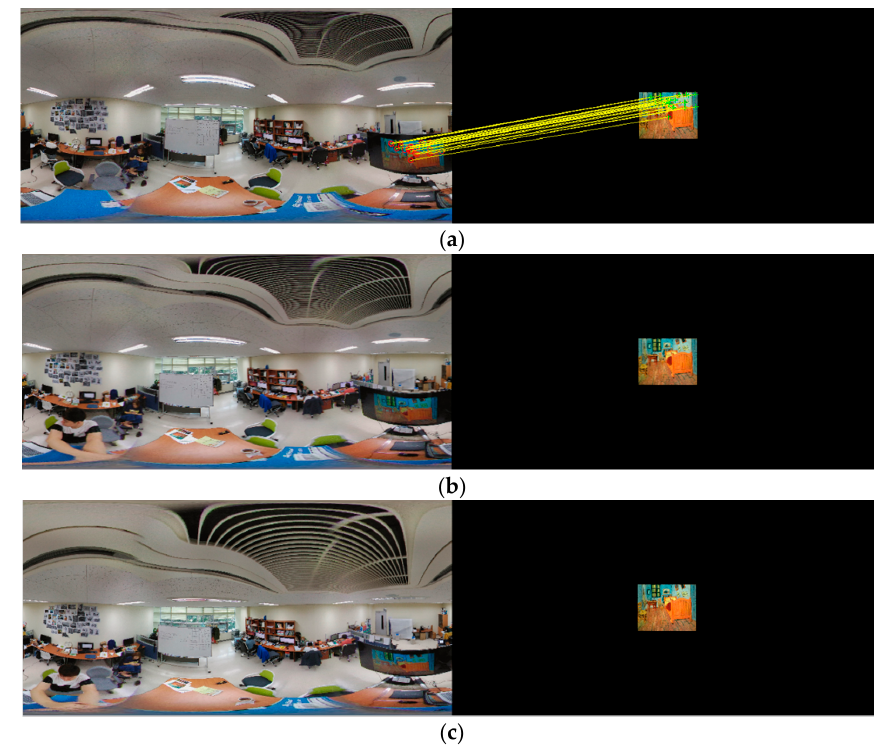
Figure 12. Matched results for the 79-inch monitor for three types of distortions. ( a ) Matched results for low distortion; ( b ) Matched results for middle distortion; ( c ) Matched results for high distortion.